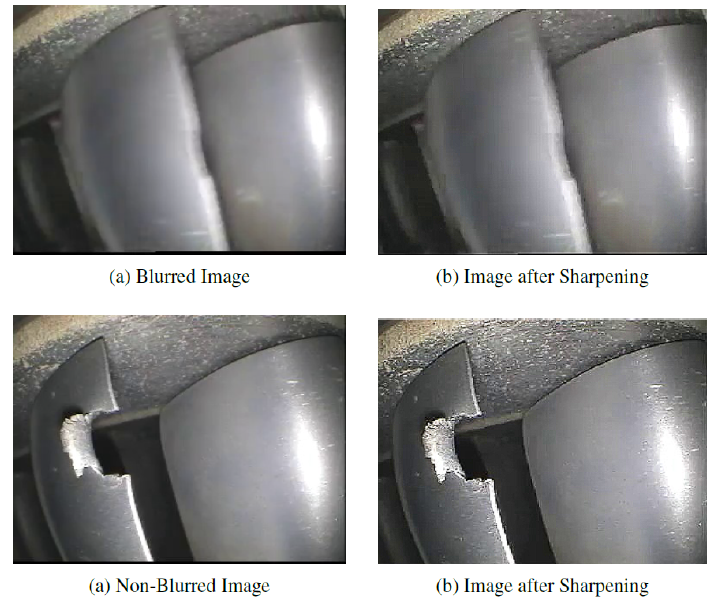
Figure 5. Image sharpening for blurred and non-blurred images.